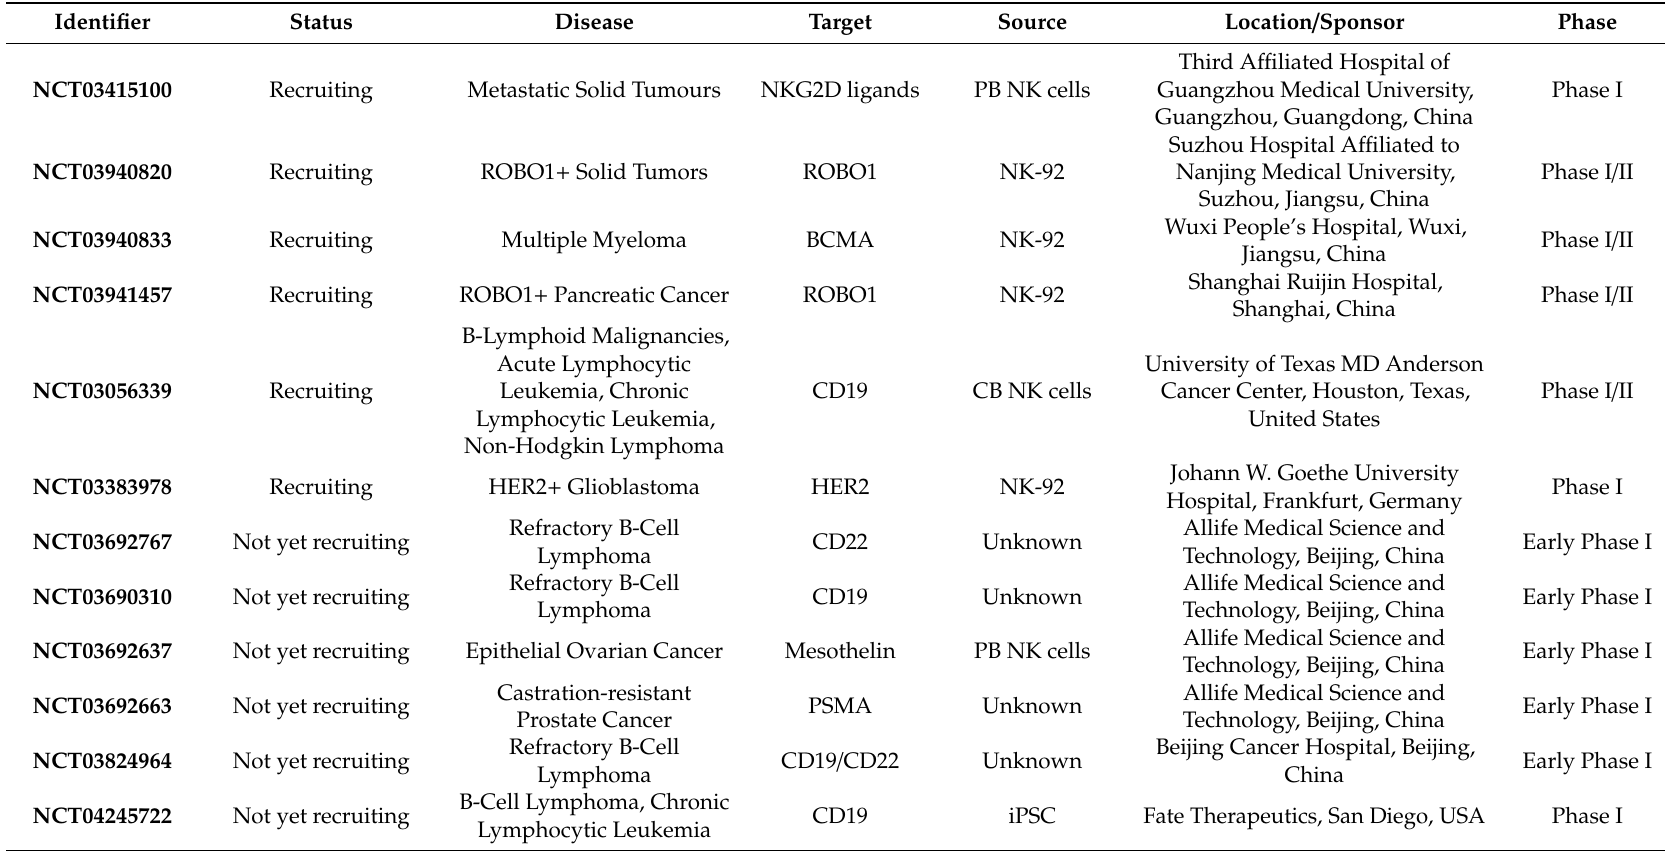
Table 1. Current clinical trials of CAR-NK cells. Clinical trials featuring CAR-NK cells against various target antigens and diseases which are currently actively recruiting or are scheduled to begin recruiting in the near future. Data was obtained from clinicaltrials.gov. Abbreviations: iPSC, induced pluripotent stem cell